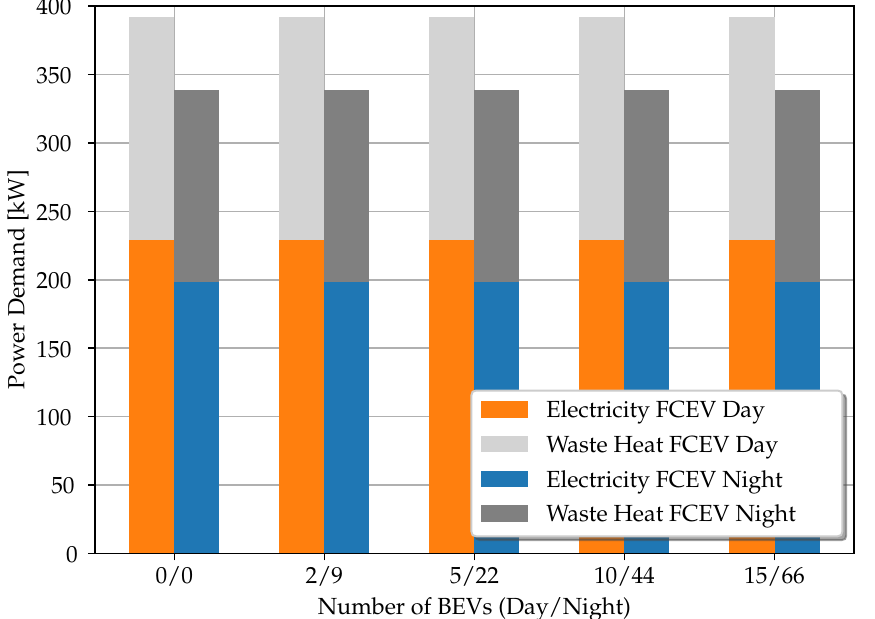
Figure 5. Power demand in the neighbourhood without storage capacities. The X-axis shows the scenarios considered resp. the relative number of employees in the neighbourhood who use a BEV daily for commuting and charge it in the neighbourhood during the other half of the day according to their working hours. The information in the brackets behind the percentage figure indicates the period in which the cars are charged (daytime/nighttime). The bars have the same meaning as in Figure